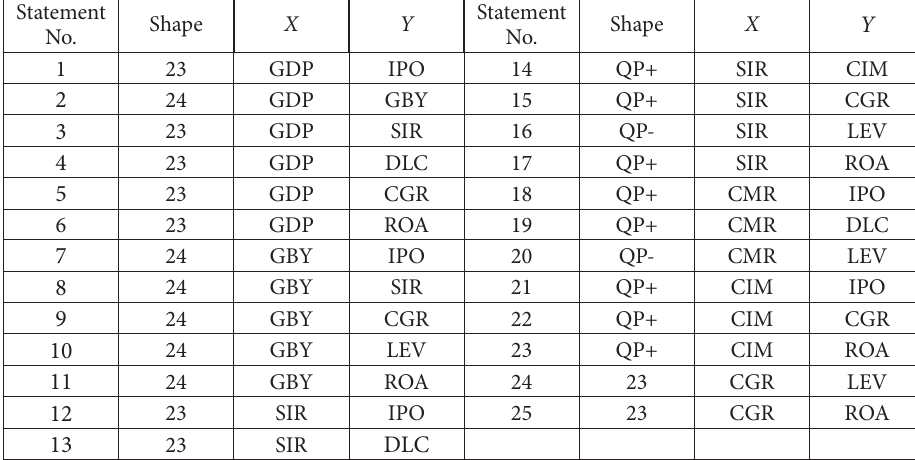
Table 2. Qualitative IPO timing model represented by a set of pair-wise relations Statement